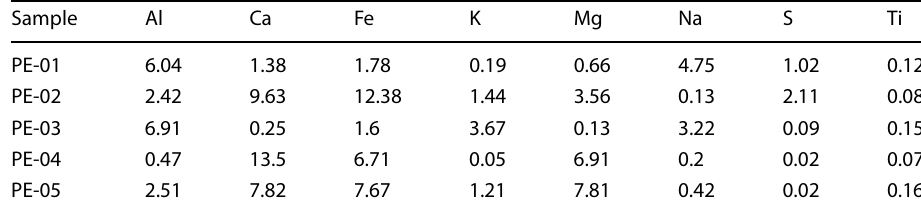
Quantities given are in ppm Data in bold correspond to the samples with the highest (PE02) and with the lowest (PE-05) concentration of rare-earth Table 2 Concentration of different elements obtained with Inductively coupled plasma in 5 different samples extracted from Capacsaya